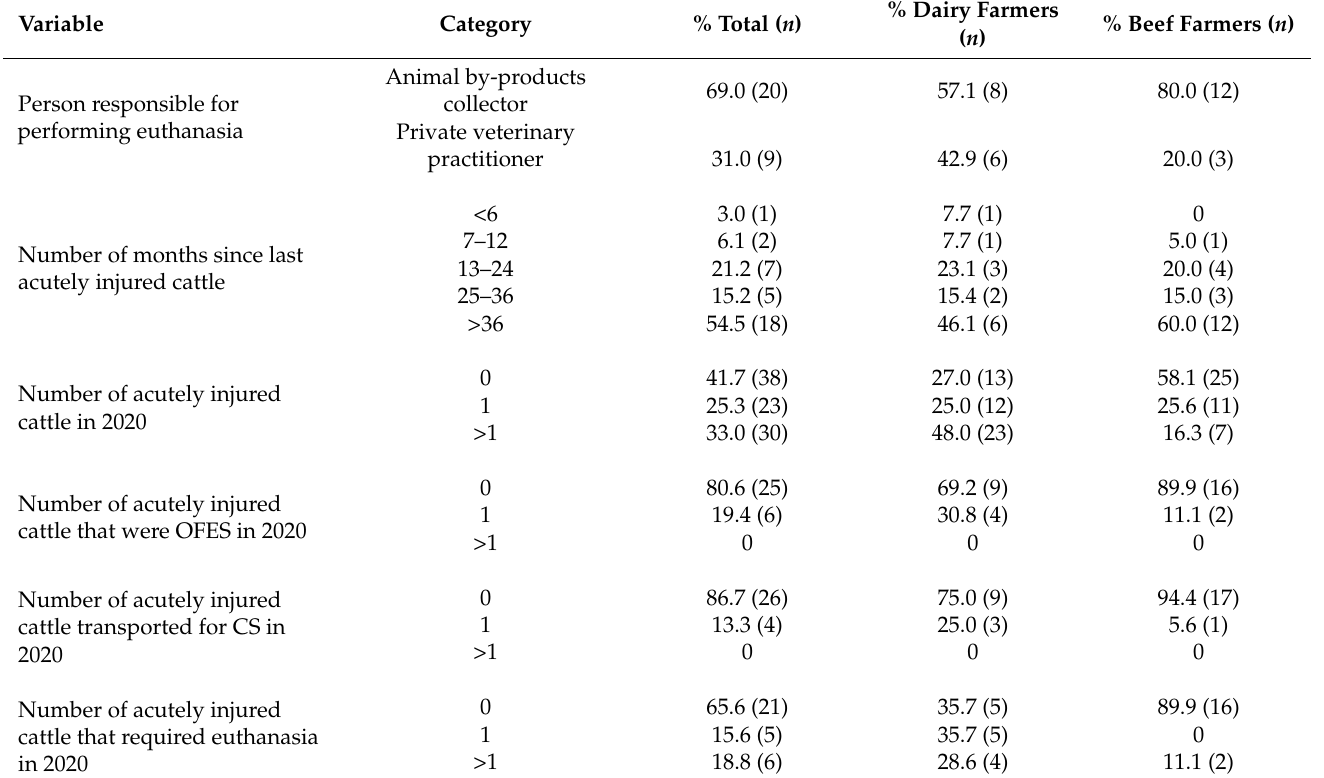
Table 2. Management of Acutely Injured Cattle by Dairy and Beef Farmers in Ireland